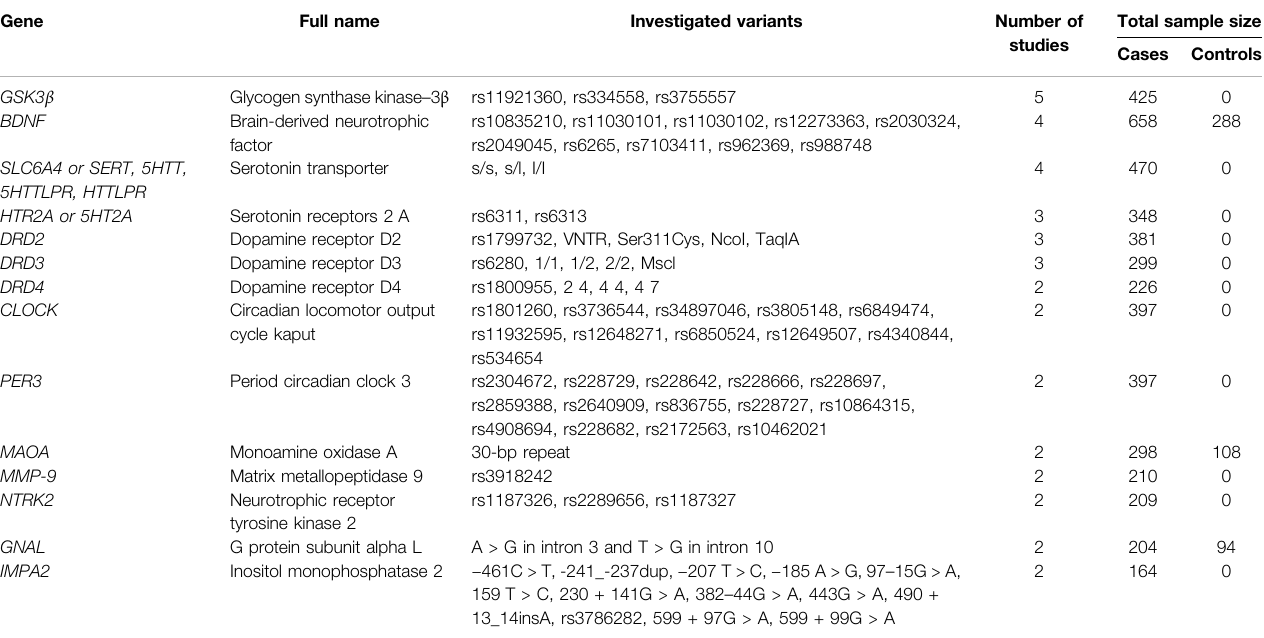
TABLE 2 | Characteristics of gene studies that found no evidence for effect on lithium response. Only those genes are listed where at least two studies reported the same